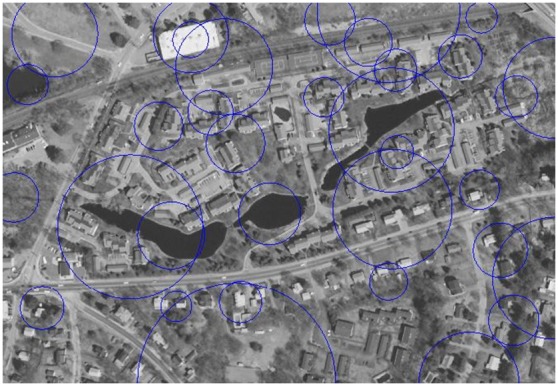
Image partitioning.